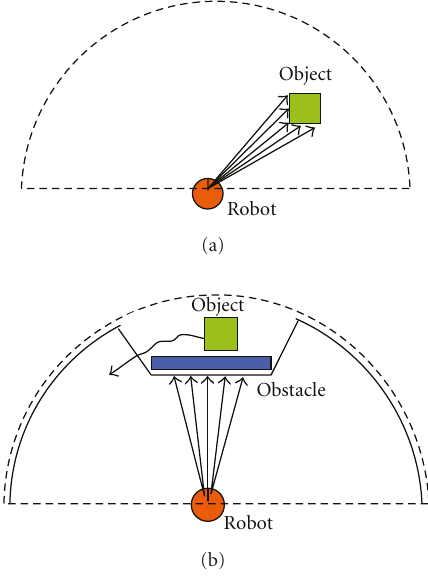
Figure 1: A fully observable object and a partially observable object. The dash line is the scan range of laser, the solid line is the observable range of laser for unobservable case, and the arrow is scanned points of laser. (a) Observable moving object tracking. (b) Unobservable moving object